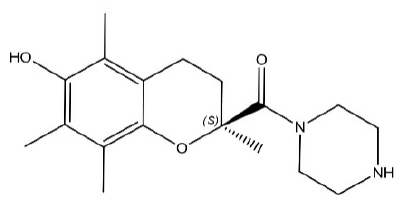
Figure 1. Chemical structure of SUL-151.